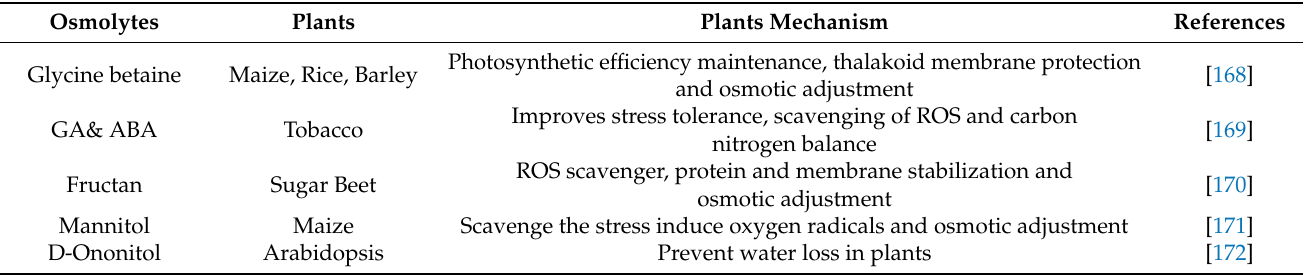
Table 4. Osmoprotectants significance in drought tolerance mechanisms different plants species. Osmolytes Plants Plants Mechanism Glycine betaine Maize, Rice,